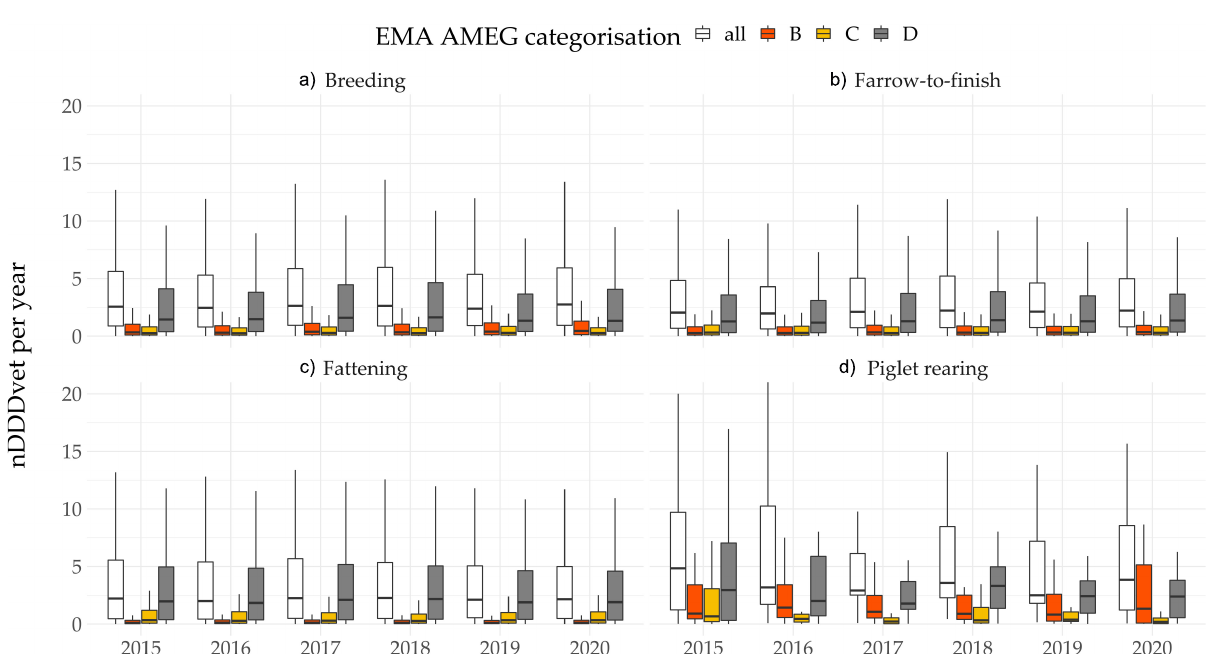
Figure 6. National recording of antimicrobials dispensed for use on a variety of pig production systems (( a ) breeding units; ( b ) farrow-to-finish farms; ( c ) fattening farms; ( d ) piglet-rearing units) by European Medicines Agency antimicrobial category (B, C, D) and